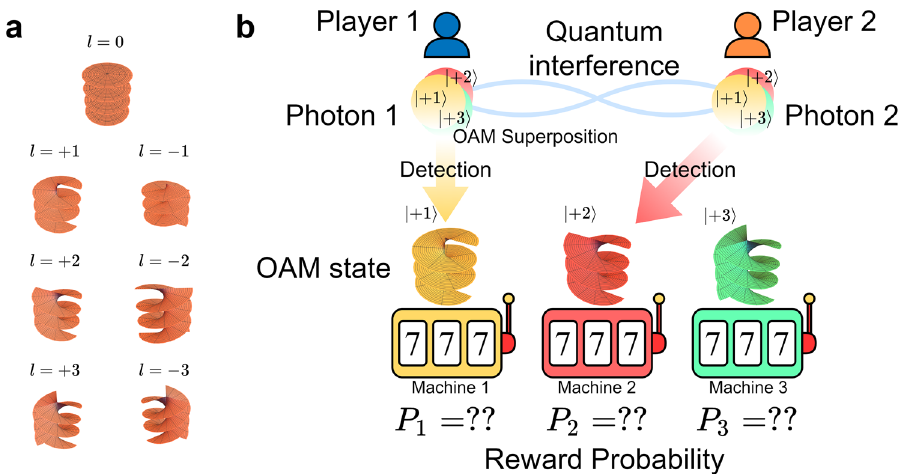
Figure 1. (a) Schematic illustration of the phase surface of a beam with OAM. The direction of travel is upward. It is a surface with | l | spirals. The pitch of each spiral is one wavelength divided by | l |. (b) Stochastic detection of OAM states directly corresponds to a player probabilistically selecting a